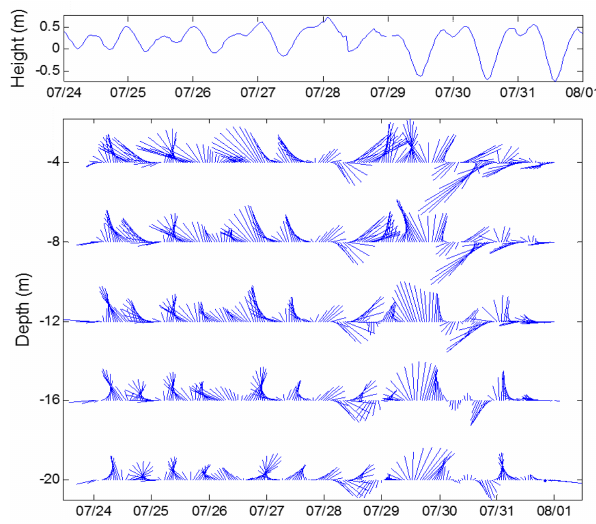
Figure 9. Current profile and corresponding tide level observed in Longdong during Typhoon Fungwong in 2008.